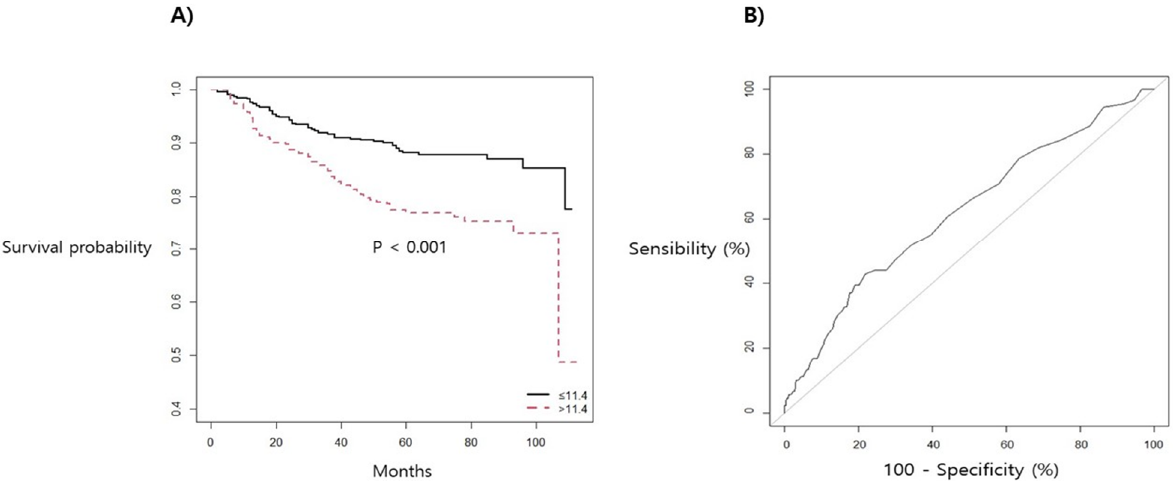
Figure 2. ( A ) Kaplan–Meier survival curve and ( B ) ROC curve for postoperative recurrence in association with CA 15-3 in patients with breast cancer surgery.